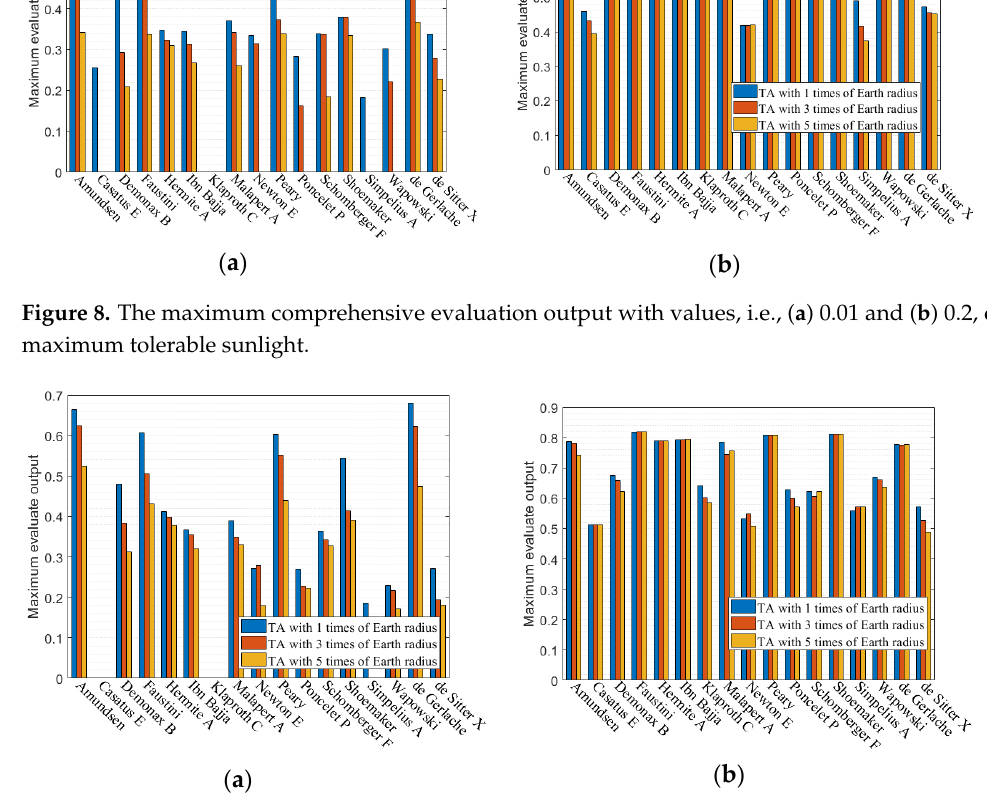
Figure 9. The maximum comprehensive evaluation output with values, i.e., ( a ) 0.01 and 0.02 and ( b ) 0.1 and 0.2, of different optimal and maximum tolerable sunlight.